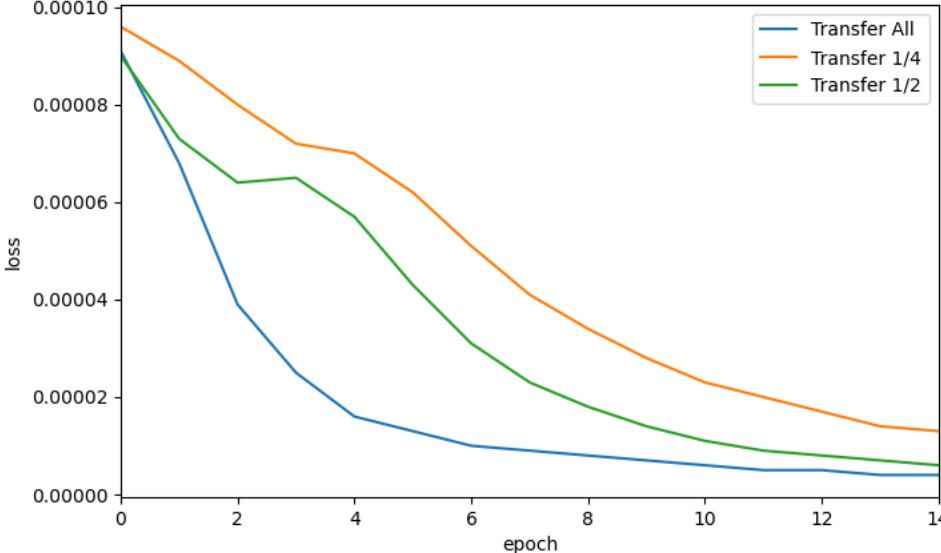
Figure 16. The learning curve on the real dataset. To find out whether a smaller number of real images is sufficient for training with transfer learning, all/half/a quarter of the real dataset was used to train. The learning curve shown in Figure 17 indicates that more real images have less training loss. Moreover, half of the real dataset with transfer learning can achieve similar performance compared to the whole real dataset without transfer learning, which means much less tedious work of manual labeling.